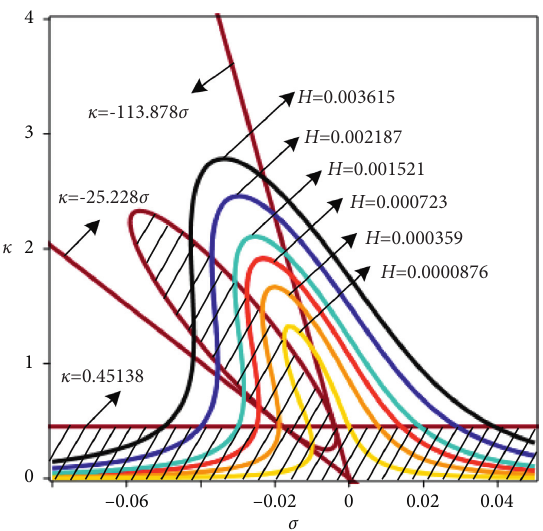
Figure 21: The amplitude-frequency response curve under dif- ferent excitation